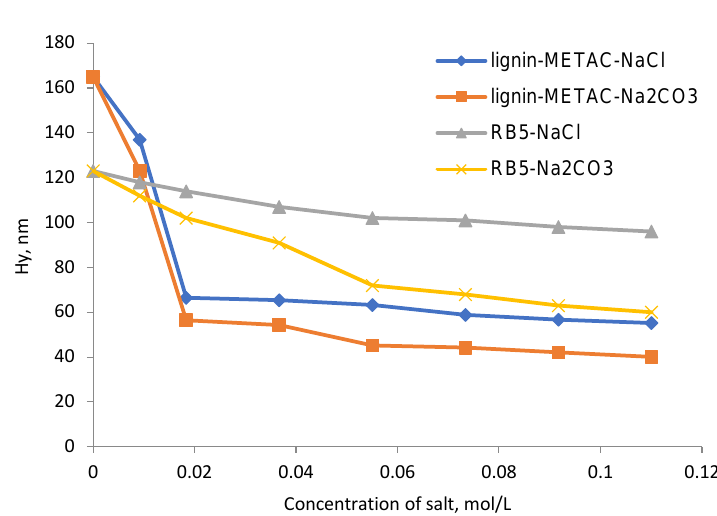
Figure 9. Hydrodynamic diameter (Hy) of lignin-METAC (sample 4) and dye RB5 in solutions containing NaCl or Na 2 CO 3 , pH 6, 30 °C.